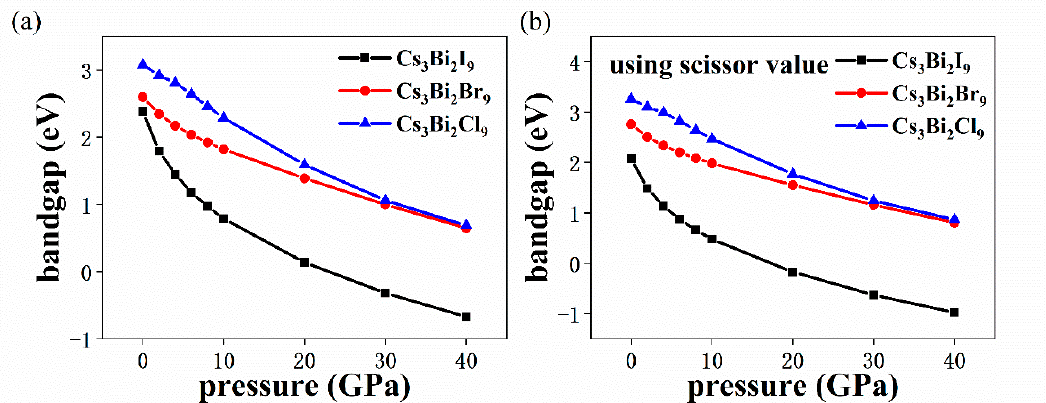
Figure 6. Calculated bandgap of the Cs 3 Bi 2 X 9 perovskites as a function of pressure (from 0 GPa to 40 GPa) ( a ). Changes in the bandgap of the Cs 3 Bi 2 X 9 perovskite after using the scissor values under HP ( b ). The black, red, and blue lines represent the Cs 3 Bi 2 I 9 , Cs 3 Bi 2 Br 9 , and Cs 3 Bi 2 Cl 9 perovskites, respectively.